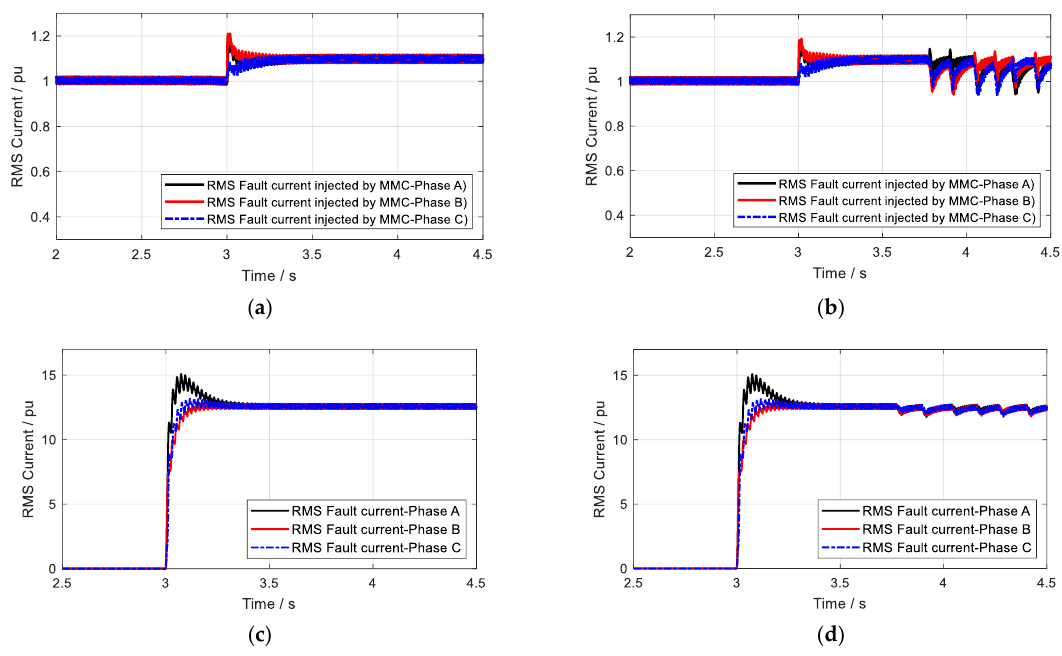
Figure 15. The simulation situations in case 5. ( a ) The RMS short-circuit current injected by the MMC after the fault with an adaptive capacitor. ( b ) The RMS short-circuit current injected by the MMC after the fault without an adaptive capacitor. ( c ) The RMS short-circuit current of the whole system after the fault with an adaptive capacitor. ( d ) The RMS short-circuit current of the whole system after the fault without an adaptive